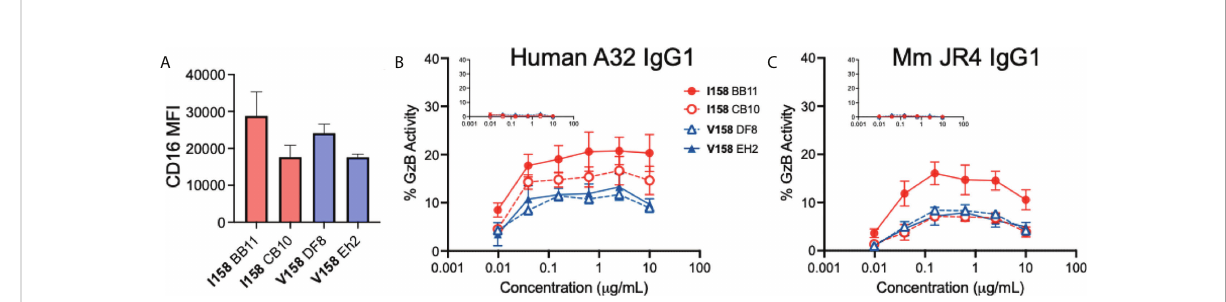
FIGURE 1 Antibody-dependent cell-mediated cytotoxicity activities (ADCC) of NK-92 clones transduced to express Macaca mulatta (Mm) FCGR3A with SNPs at position 158. (A) Median fl uorescent intensity (MFI) of cell surface CD16 (Fc g RIII) on NK-92 clones with Ile 158 (n=2, red) and Val 158 (n=2, blue) SNPs. ADCC activity of (B) human and (C) Mm IgG1 speci fi c for the HIV-1 Env cluster A region (monoclonal antibodies A32 and JR4, respectively) in assays performed with NK-92 clones expressing the Ile 158 (red lines) and Val 158 (blue lines) variants of Fc g RIII. Inset graphs represents activity observed with an in fl uenza speci fi c negative control antibody, CH65, produced as human and Mm IgG1. Data represents mean and standard error from four independent